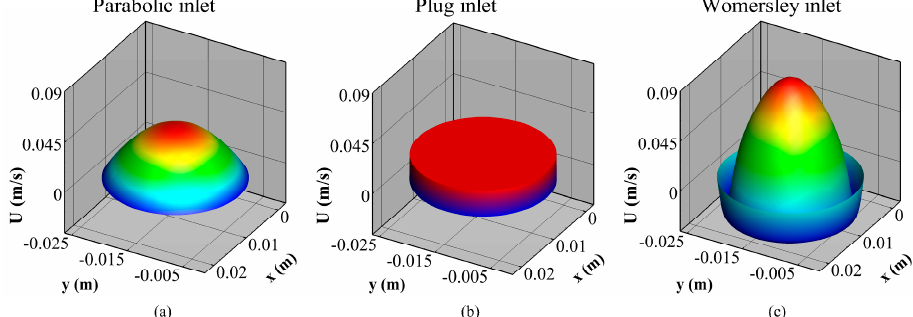
Figure 3. Parabolic ( a ), Plug ( b ), and Womersley ( c ) inlet velocity distribution profiles at the beginning of the cardiac cycle.